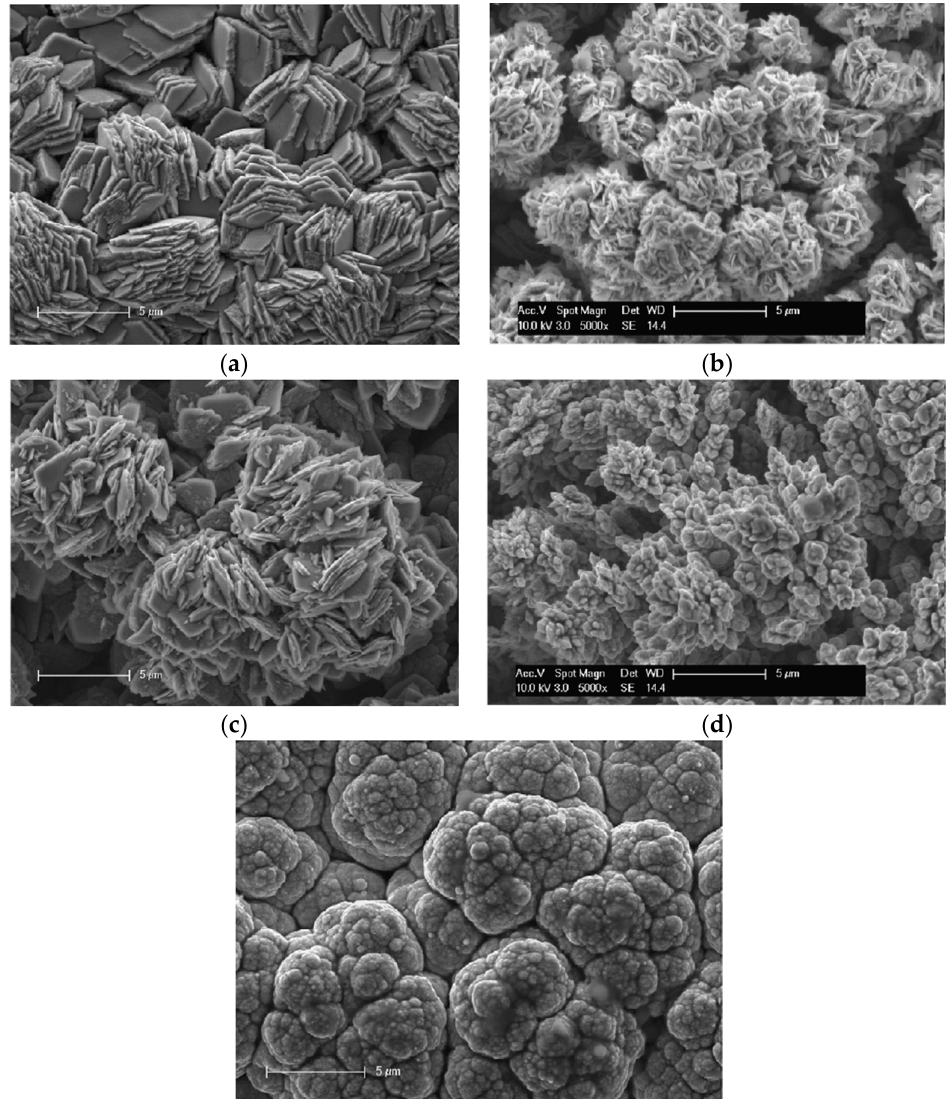
Figure 8. SEM micrographs of Ni–Co deposits obtained at a current density 65 mA cm − 2 from an electrolyte with different Ni 2+ /Co 2+ concentration ratio: ( a ) 0.25, ( b ) 0.5, ( c ) 1, ( d ) 2 and ( e ) 4 [106].